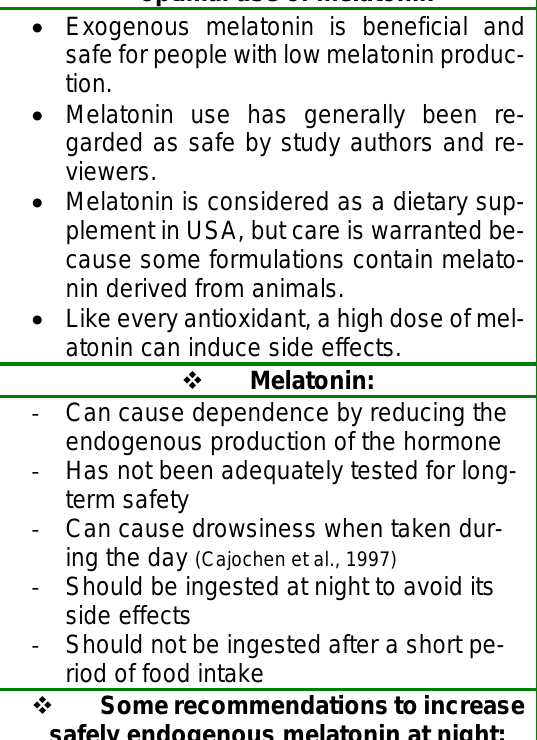
Table 1: Fight Coronavirus disease of 2019 (COVID-19) and boost immunity by increasing en- dogenous melatonin levels. Concrete tips for